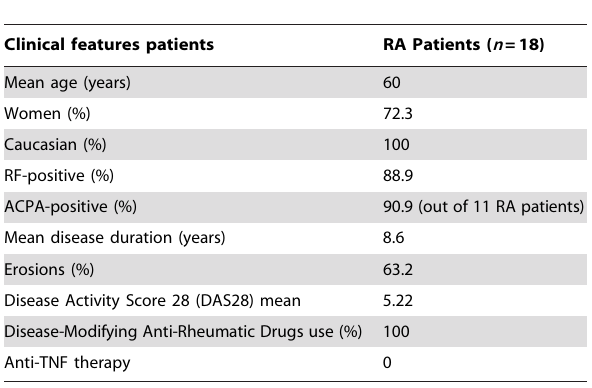
Table 1. Clinical and demographic characteristics of the RA